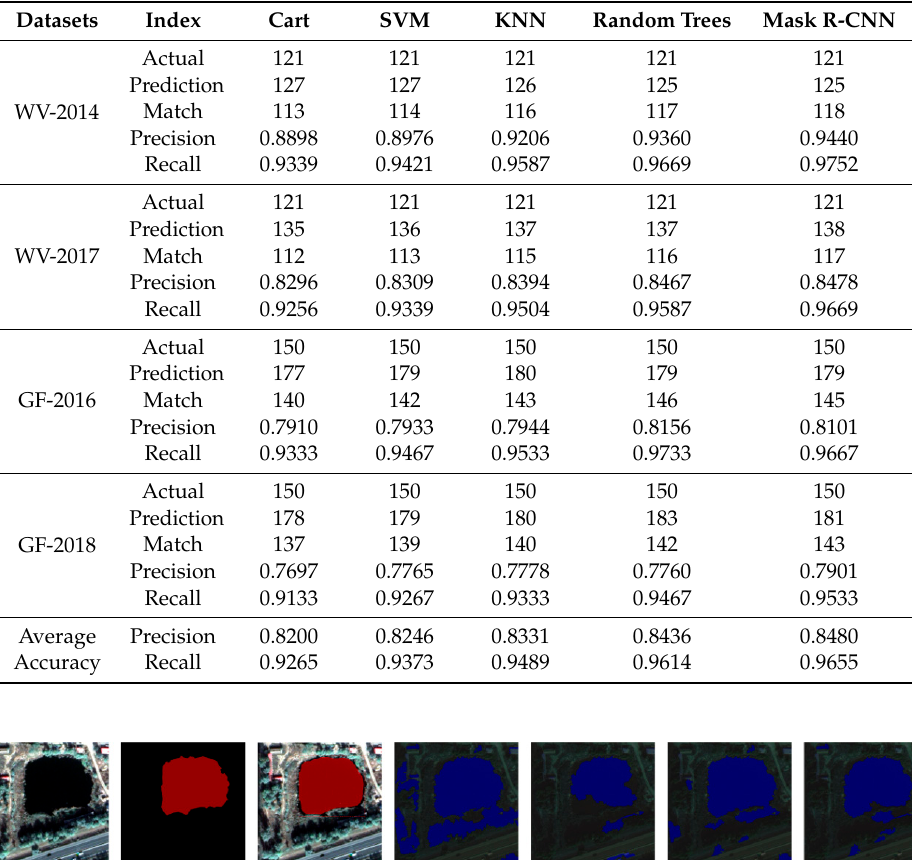
Table 8. Water recognition accuracy of di ff erent methods in four di ff erent test